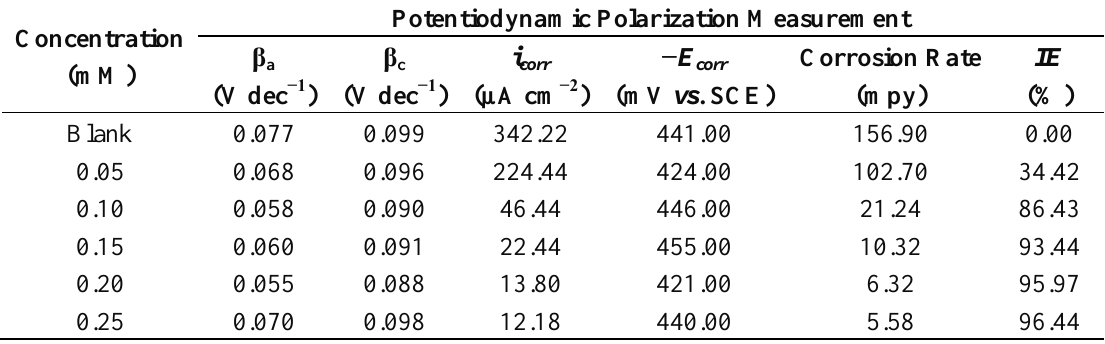
Table 3. Polarization parameters for mild steel in 1.0 M H concentrations of the corrosion inhibitor at 30 °C. mpy, milli-inch per